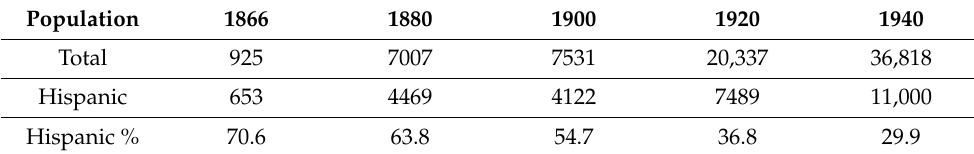
Table 1. Population in Tucson,